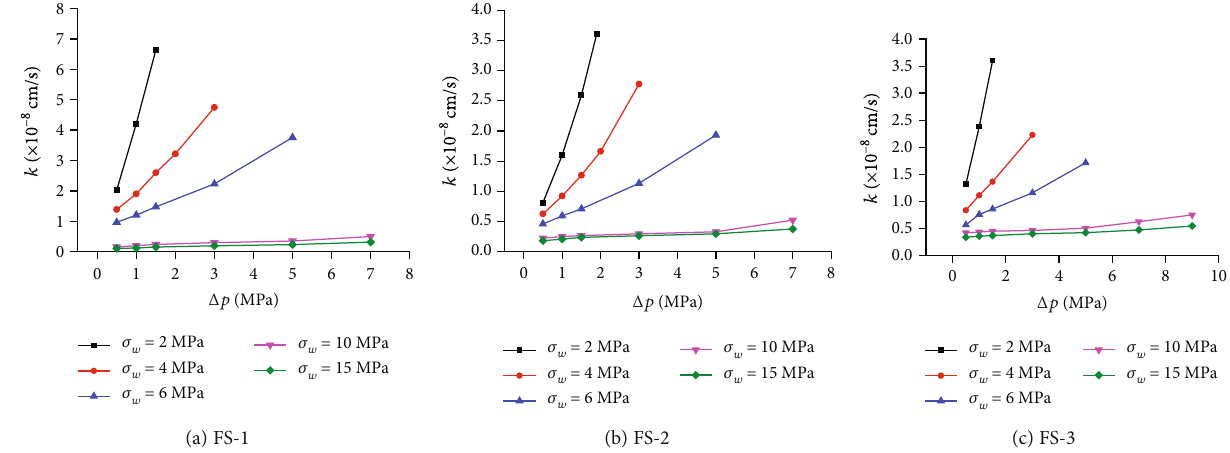
Figure 15: Relationship between permeability coe ffi cient and water pressure for FS.